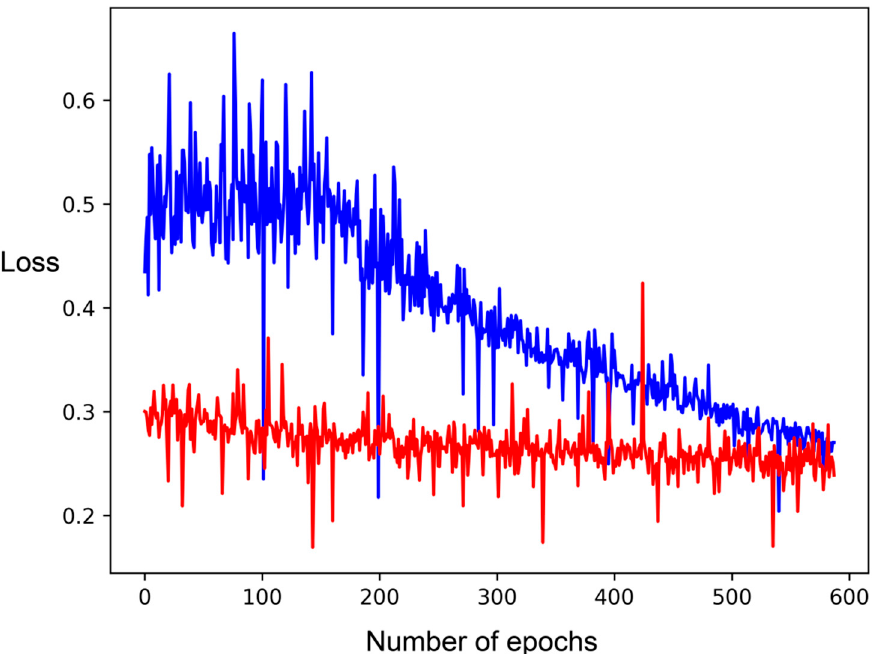
Figure 9. Loss functions of training (blue) and validation (red) datasets by number of epochs in DNN with user-defined features (II).